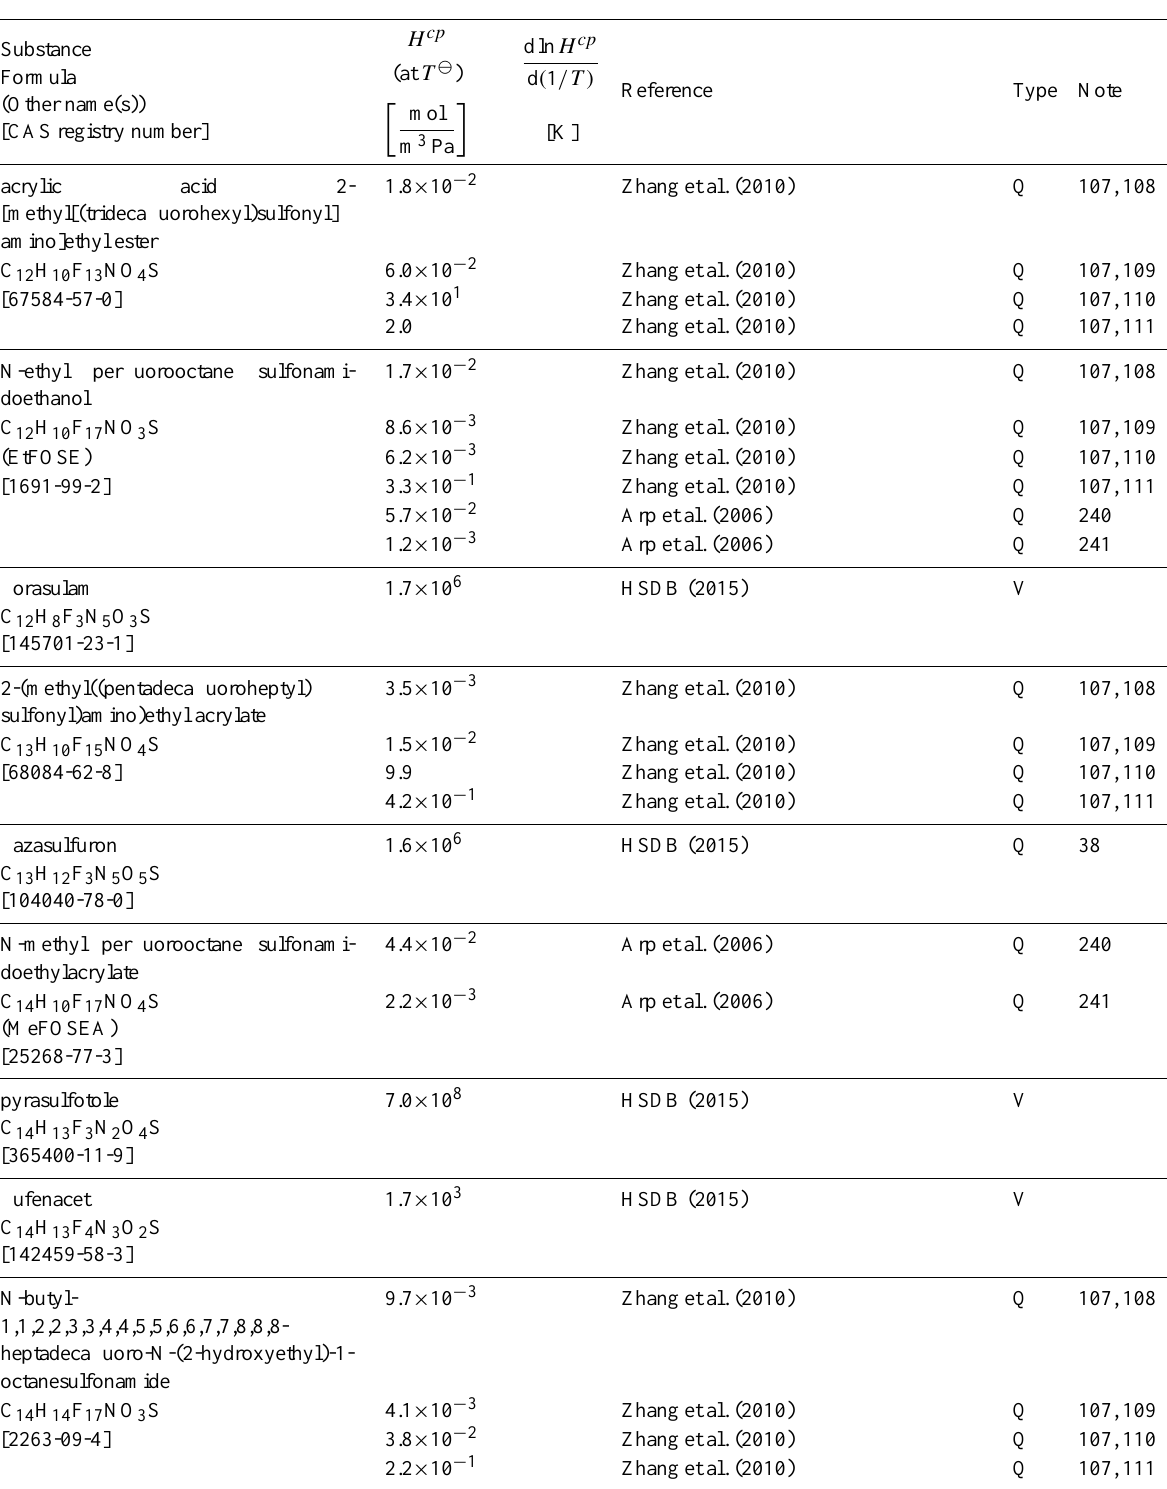
Table 6: Henry’s law constants for water as solvent